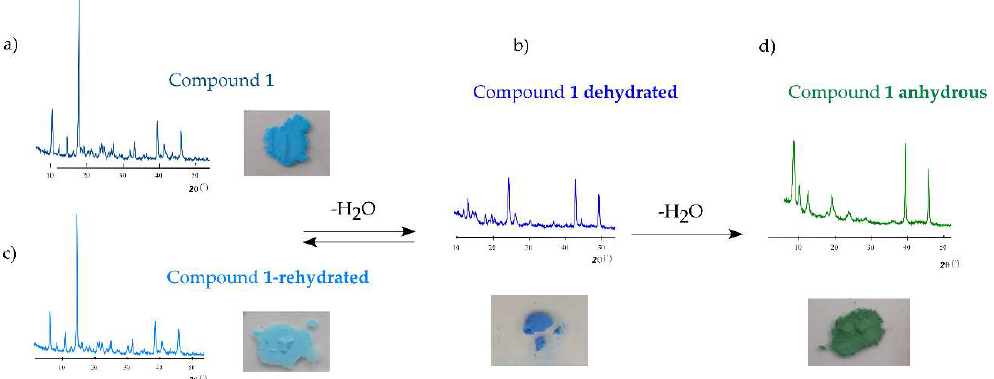
Figure 4. Powder X-ray diffraction patterns and photographs displaying the color of powdered samples of 1 ( a ) at room temperature, ( b ) after being heated at 90 ◦ C, ( c ) after being heated at 90 ◦ C samples of 1 ( a ) at room temperature, ( b ) after being heated at 90 °C, ( c ) after being heated at 90 °C and rehydrated in open air conditions, ( d ) after being heated at 200 ◦ C. The reversibility of such and rehydrated in open air conditions, ( d ) after being heated at 200 °C. The reversibility of such transformations is also transformations is also indicated.